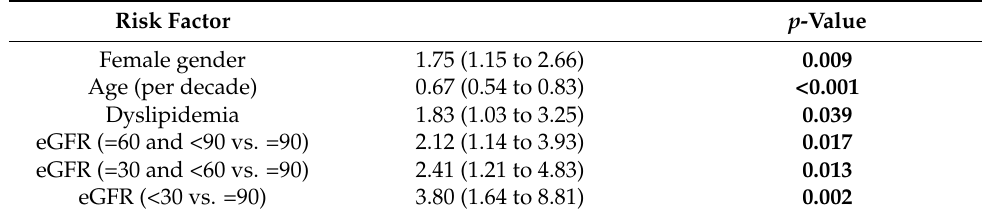
Table 3. Odds ratio to receive CD-TLR for all risk factors in the final